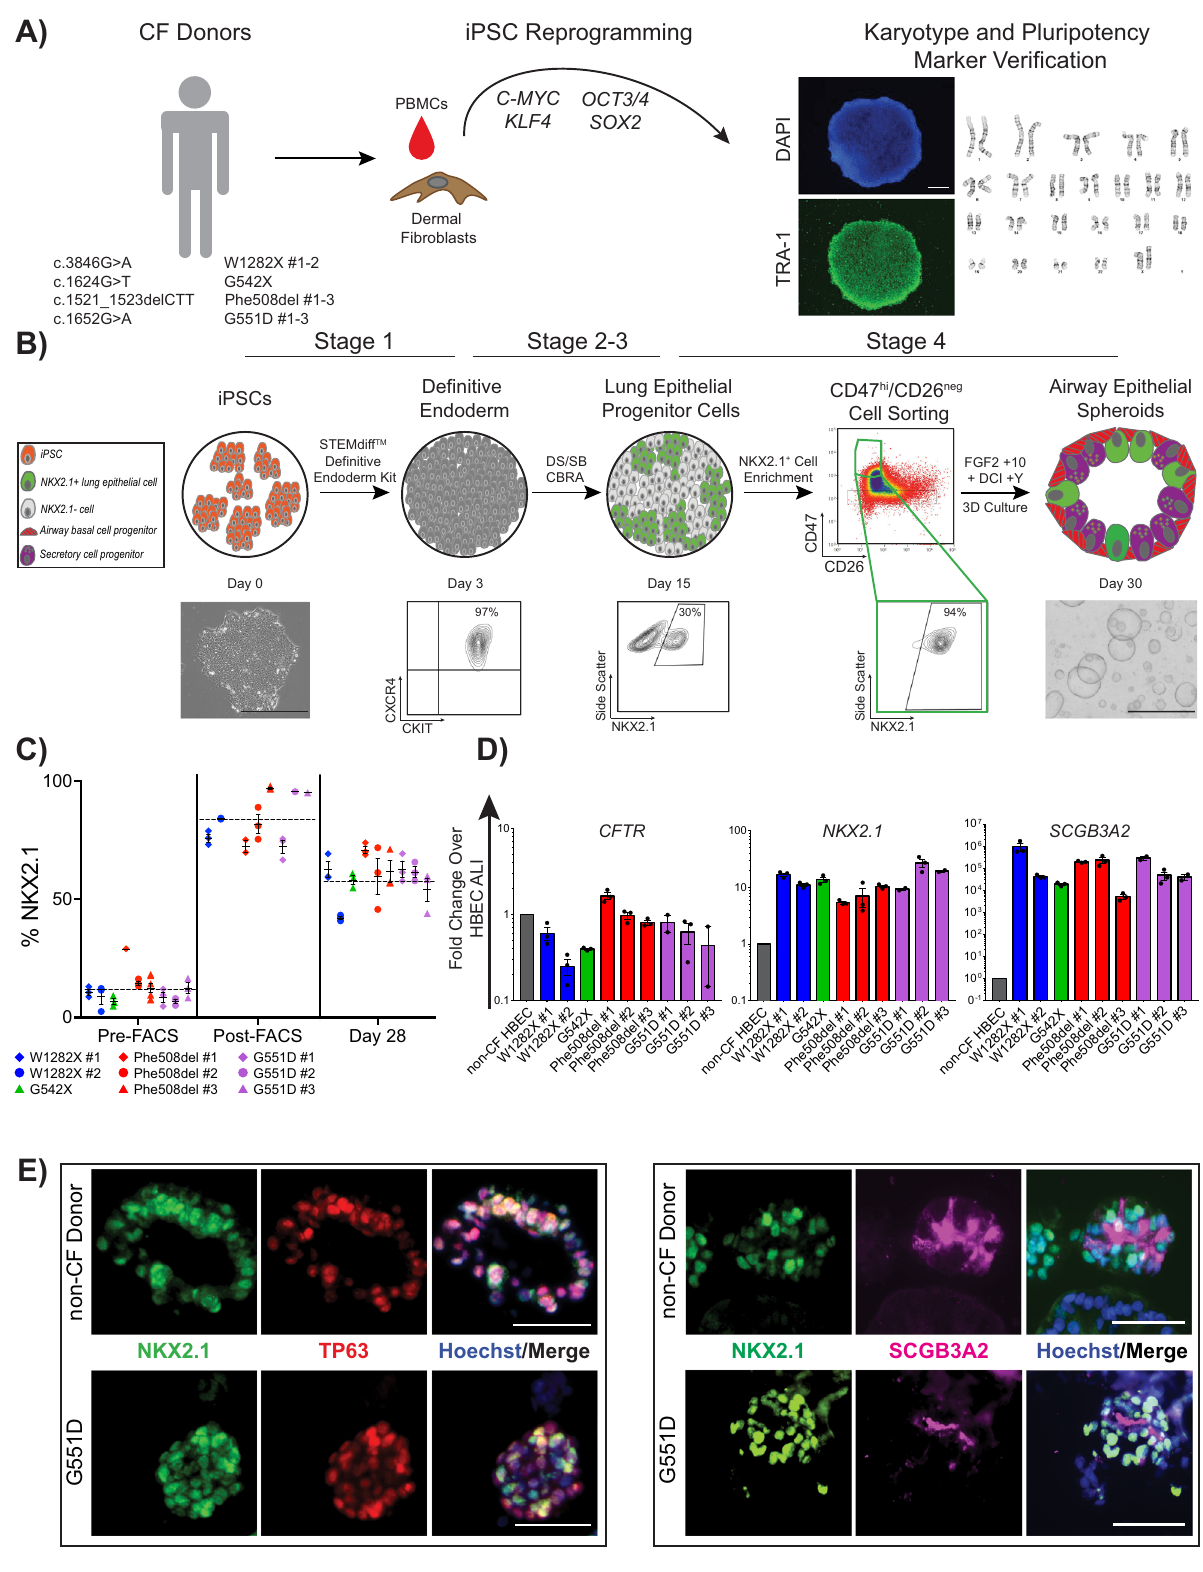
To more broadly assess the forskolin effect between multiple thin-walled, and had a hollow central lumen which increased in non-CF genetic backgrounds ( n = 3 cell lines) we generated size after forskolin treatment (Fig. 2D, insets); average cell airway epithelial cell spheroids from the remaining non-CF iPSC numbers per well were similar amongst all samples (Supplemen- lines (non-CF #1, 3) ( n = 3 experiments per line) (Fig. 2C). tary Fig. 4). We imaged live airway epithelial cell spheroids Morphologically, non-CF spheroids were heterogeneous in size, immediately prior to, and 20 – 24 h after the addition of forskolin NATURE COMMUNICATIONS| (2022) 13:4270